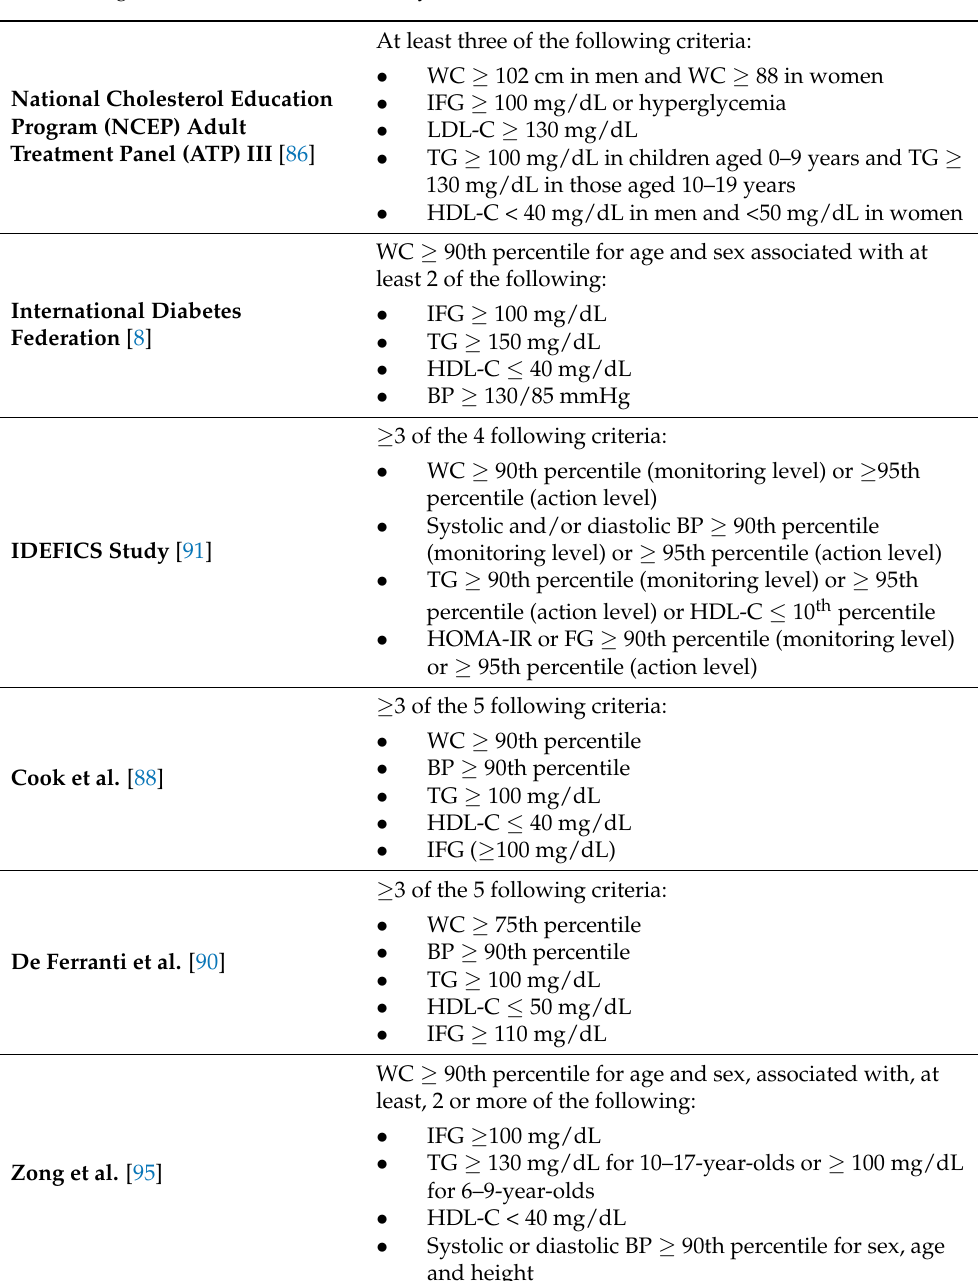
Table 1. Diagnostic criteria for Metabolic Syndrome